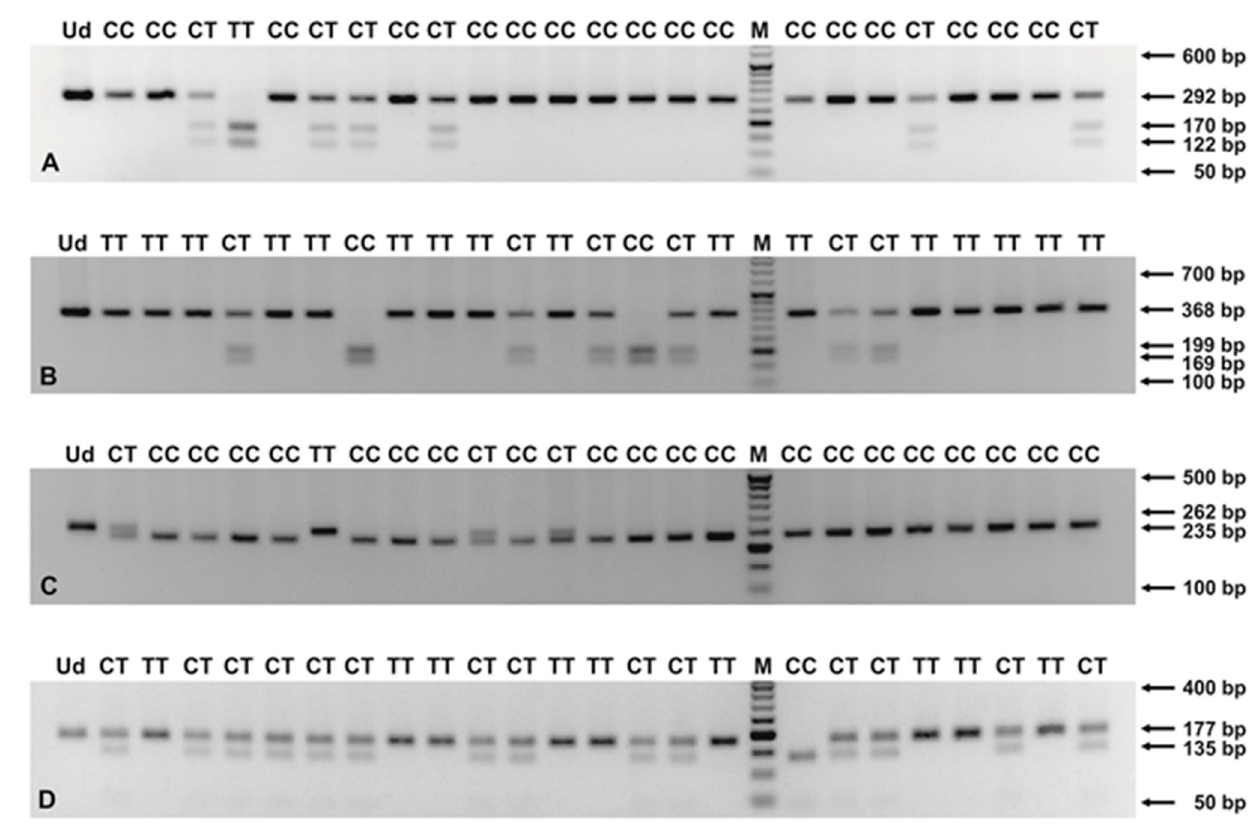
Figure 1. Products of PCR-RFLP assays for the CSF2 rs25881 ( A ), FLT1 rs722503 ( B ), TFPI C-399T ( C ) and TLR9 rs352140 ( D ) polymorphisms. Digestions were performed with the endonucleases BlpI ( A ), AvaII ( B ), HinfI ( C ) and BstUI ( D ), followed by separation in 2.5–3.0% ethidium bromide stained agarose gels. The numbers to the right of the electropherograms show the lengths of the separated DNA fragments. M: 50 bp DNA marker; Ud: undigested PCR product; CC, CT, TT: genotypes in the tested SNPs.